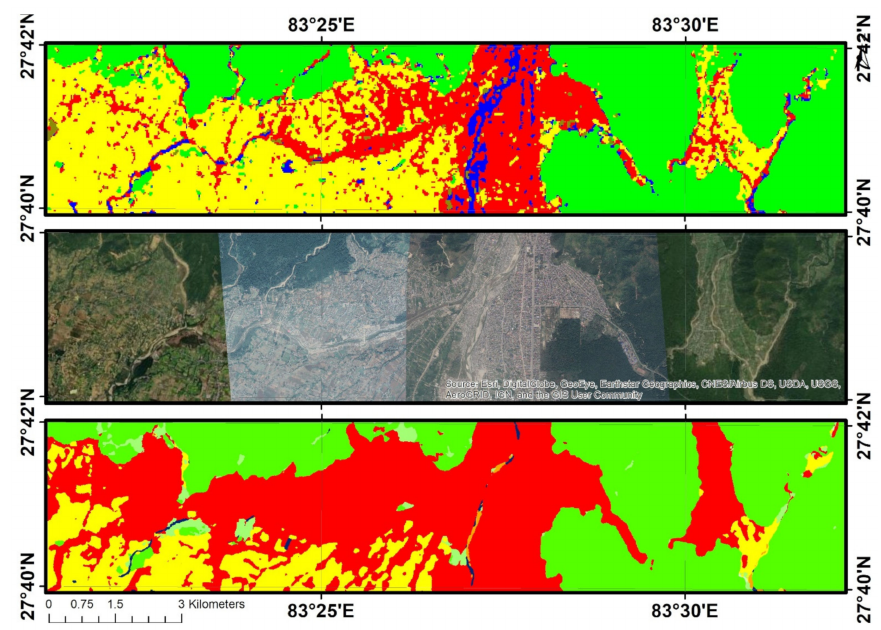
Figure 9. Comparison of LC map around Butwal and its vicinity area for the year 2020 from top to bottom: 30-meter map obtained from our study, high-resolution imagery on Google Earth Pro (GEP), and global 10-meter map prepared by ESRI using Sentinel